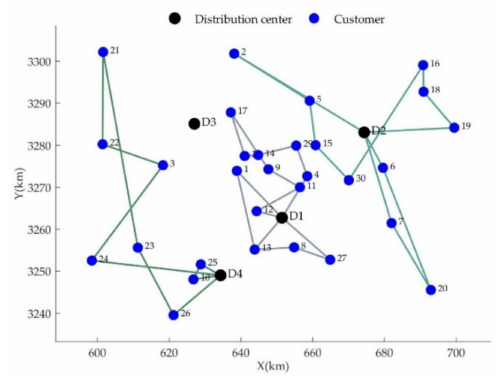
Figure 8. Location-routing scheme solved by